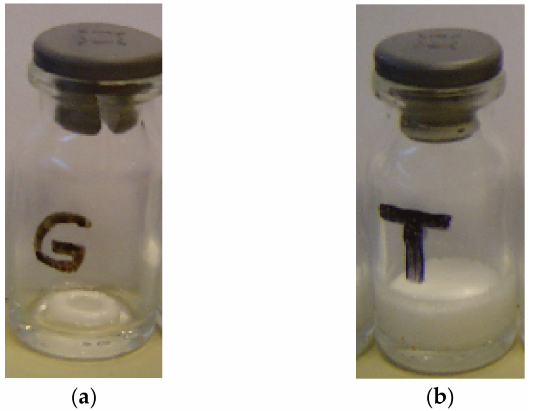
Figure 6. Photographs of collapsed and non-collapsed freeze-dried ( a ) sucrose (T c = − 30 ◦ C) and ( b ) PVP (T c = − 22 ◦